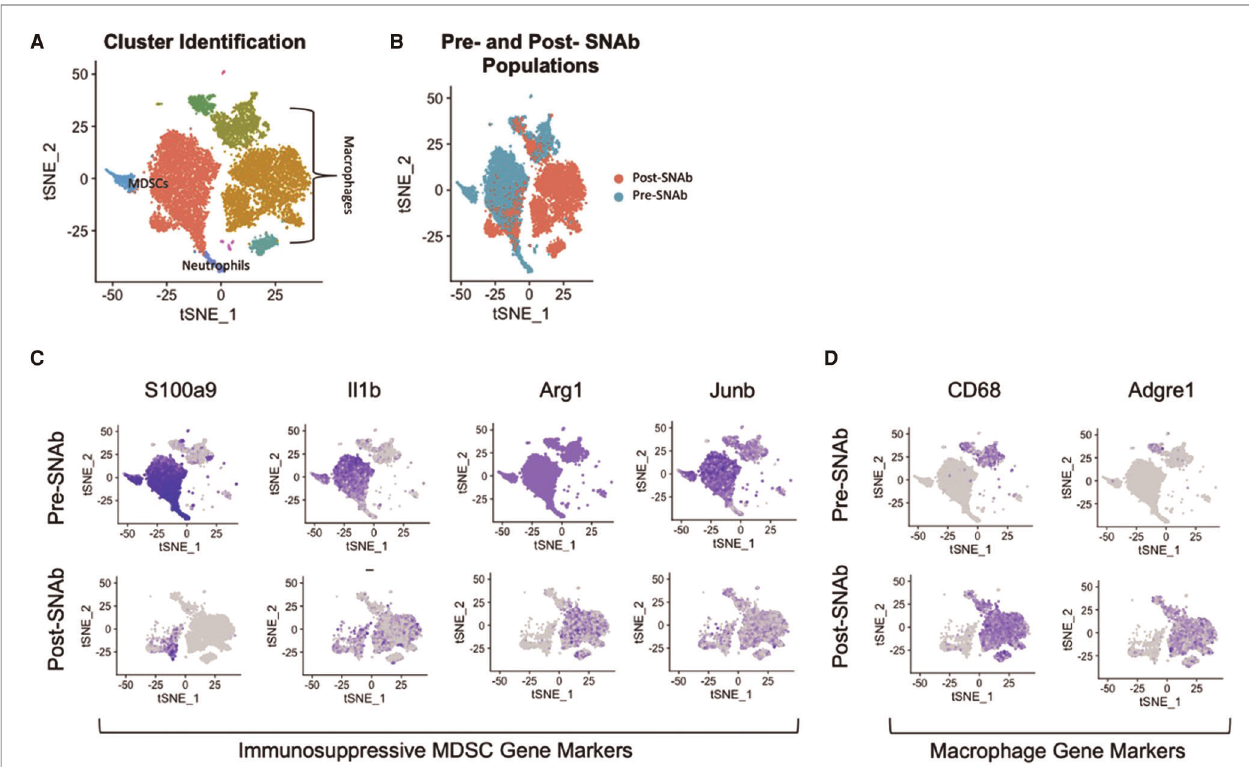
FIGURE 1 | Single cell RNA sequencing of MDSC depletion in vitro. ( A ) Clustering of integrated tSNE plots from the SNAb-treated and untreated cells enriched for MDSCs. ( B ) Overlay of tSNE plots from SNAb-treated and untreated groups showing differences in cell populations. ( C ) Gene expression for immunosuppressive MDSCs gene markers ( S100a9 , IL1b , Arg1 , and Junb ) pre- and post-SNAb treatment. ( D ) Gene expression for macrophage gene markers ( CD68 and Adgre1 ) pre- and post-SNAb